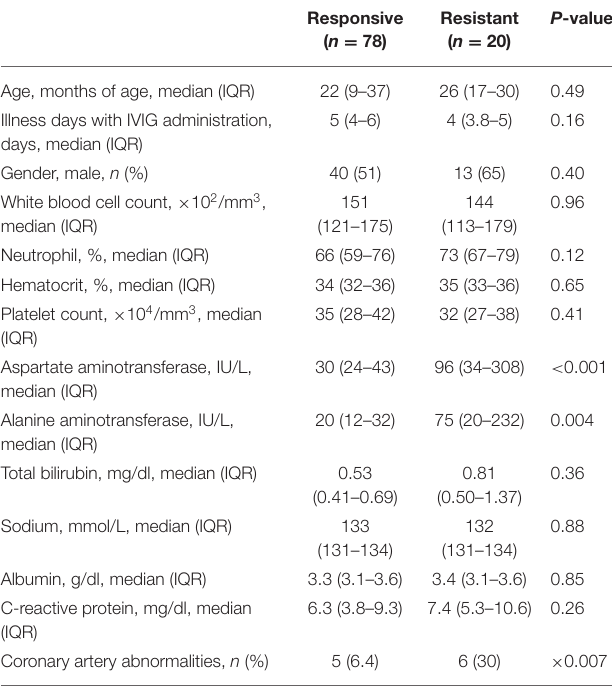
TABLE 1 | Comparison of clinical and laboratory characteristics in IVIG-responsive and -resistant